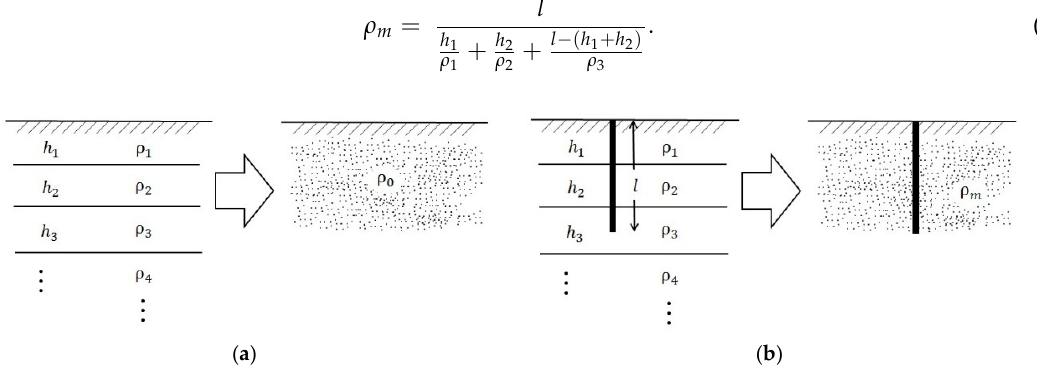
Figure 2. Equivalent resistivity of a multilayer. ( a ) Without driven rod; ( b ) with driven rod.